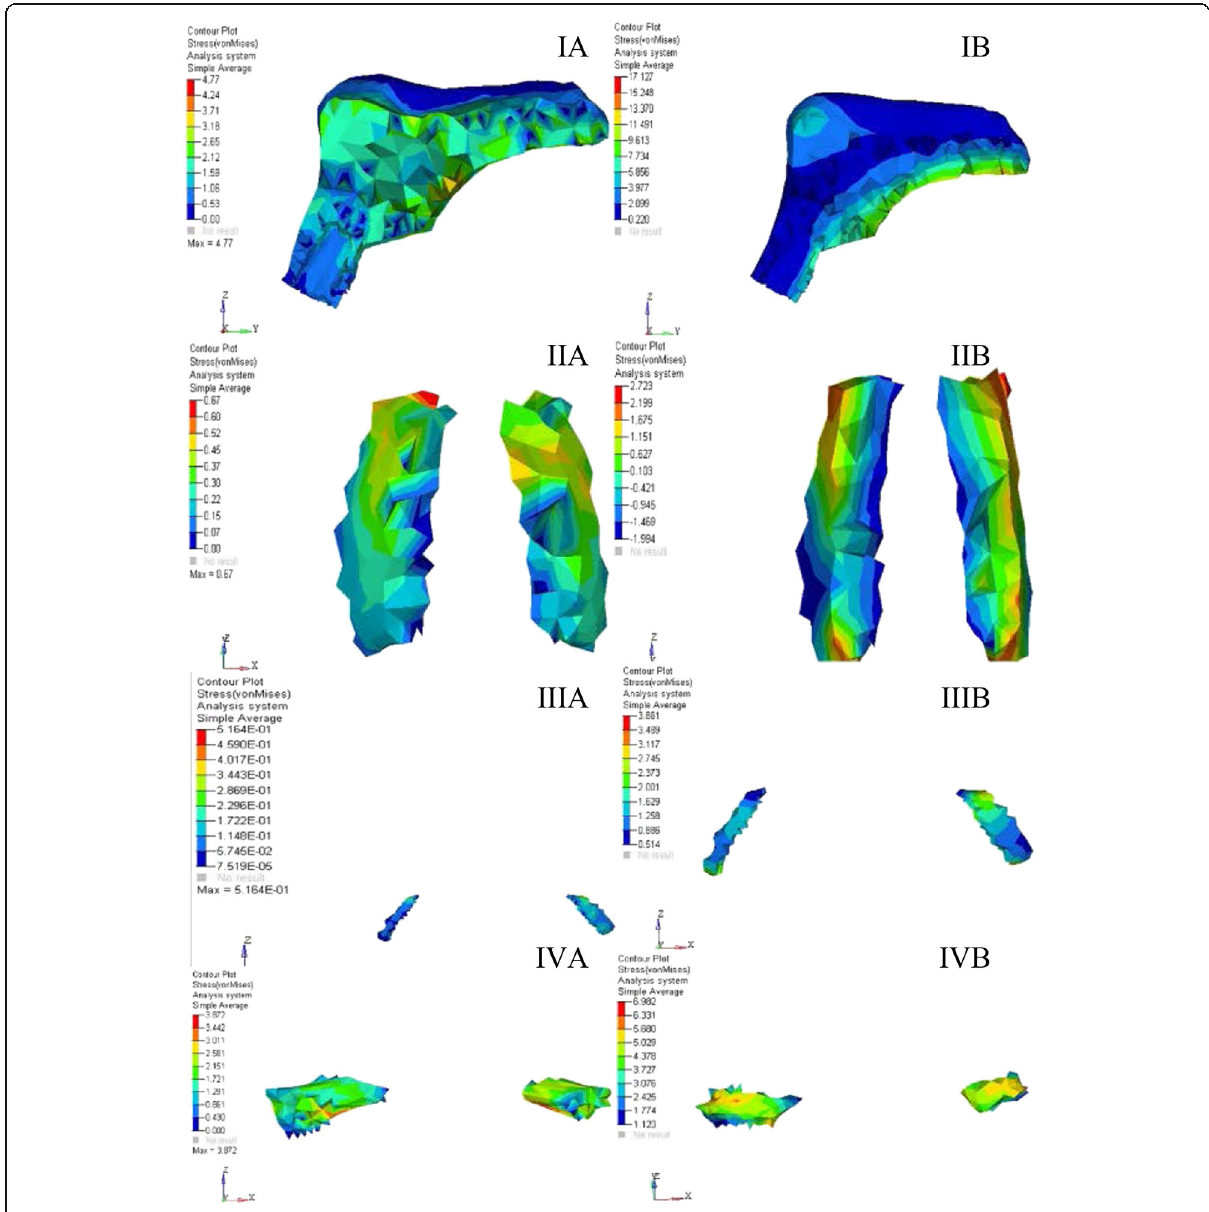
Fig. 7 von Mises stresses at different sutures for A RME. B Implant-supported RME. IA , IB Midpalatal suture. IIA , IIB Naso-maxillary suture. IIIA , IIIB Zygomatico-maxillary suture. IVA , IVB Pterygo-maxillary